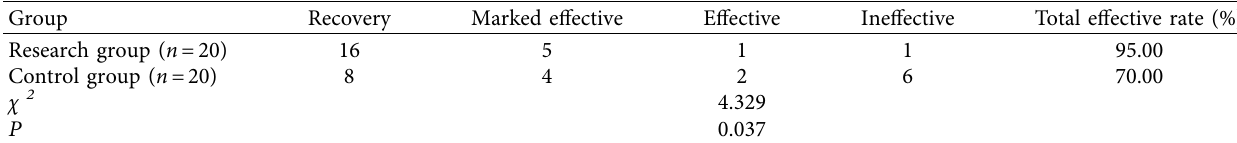
Table 5: Comparison of clinical effects of patients with different treatment methods. Group